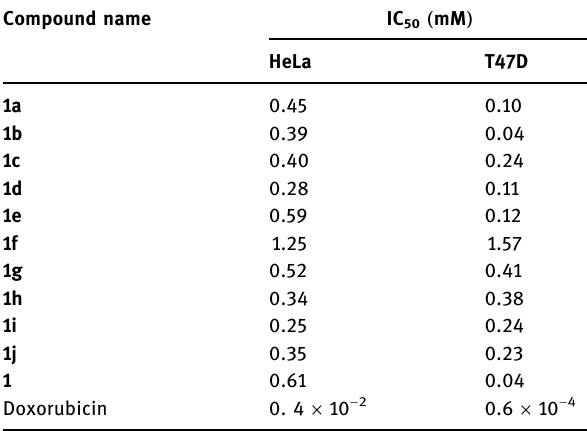
Table 2: Investigation of the cytotoxicity of the modi fi ed compounds ( 1a – 1j ) against HeLa and T47D cell lines Compound